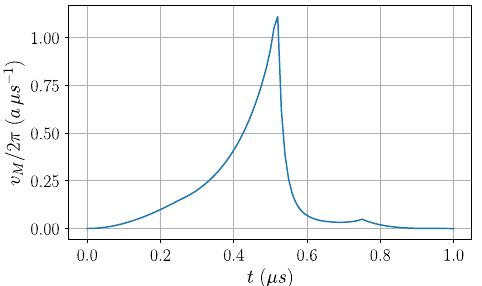
FIG. 9. The Lieb-Robinson bounds. “ Significant ” correlations spread along a light cone d ¼ 2 vt . Along and inside the light cone (grey shaded area), correlations of order O ð 1 Þ can develop. Outside the light cone, d > 2 vt correlations are immediately built up for each t > 0 , but are exponentially suppressed in d − 2 vt .